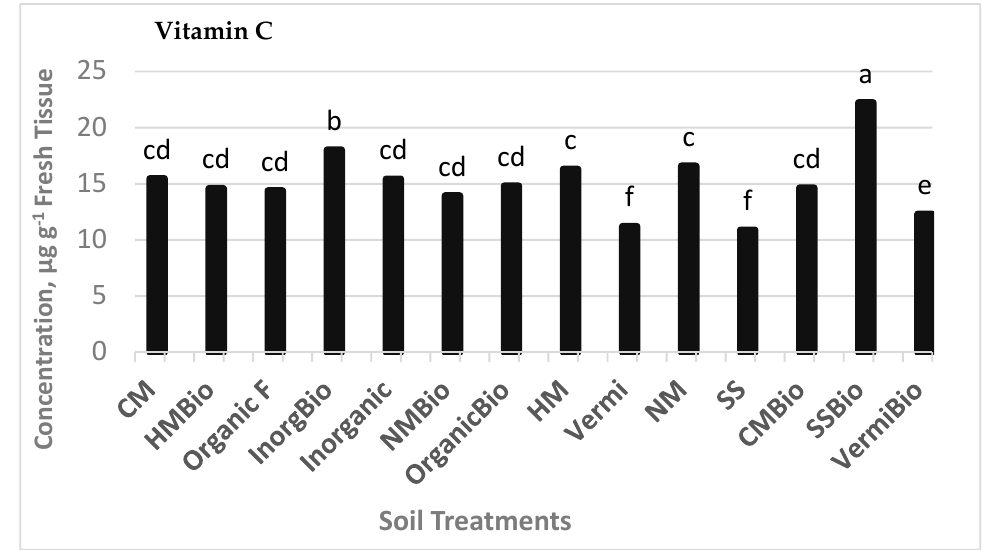
Figure 3. Concentrations of vitamin C in tomato grown in soil mixed with amendments: Vermicompost (Vermi), no ‐ mulch soil mixed with biochar (NMBio), inorganic fertilizer (Inorganic), sewage sludge mixed with biochar (SSBio), vermicompost mixed with biochar (VermiBio), inorganic fertilizer mixed with biochar (InorganicBio), chicken manure mixed with biochar (CMBio), horse manure mixed with biochar (HMBio), chicken manure (CM), horse manure (HM), organic fertilizer mixed with biochar (OrganicBio), sewage sludge (SS), no ‐ mulch bare soil (NM), and organic fertilizer (Organic). Values accompanied by the same letter(s) are not significantly different ( p > 0.05).